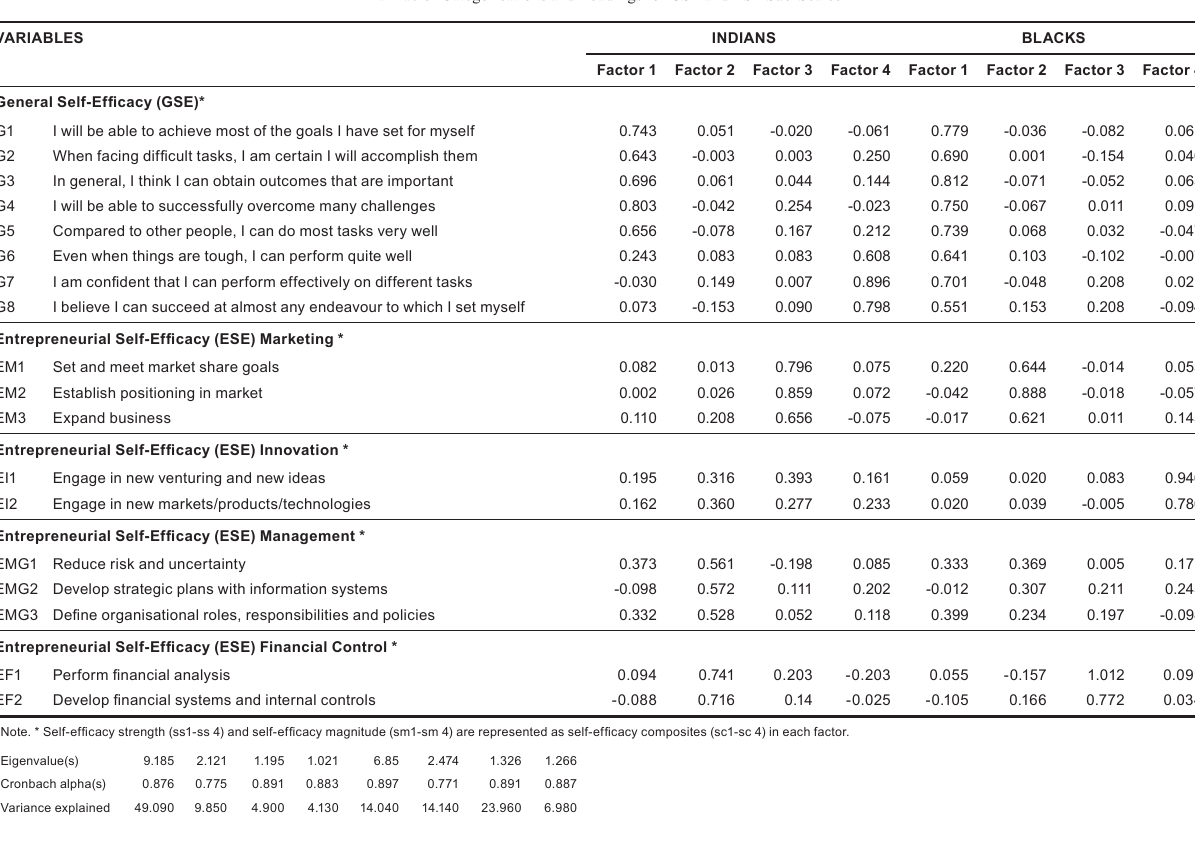
Table 2a Final Factor Categorisations and Loadings for GSE and ESE Sub-Scales